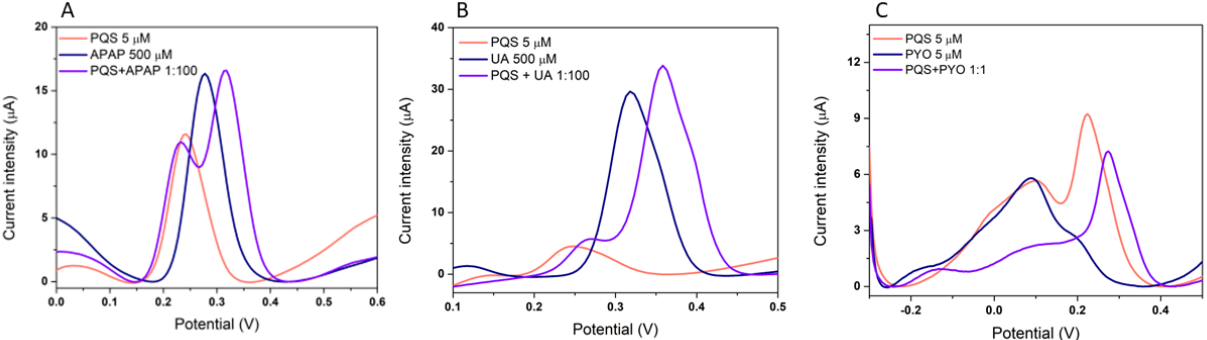
Figure 9. Interference with other electrochemically active substances: ( A ) APAP, ( B ) UA, and ( C ) PYO .